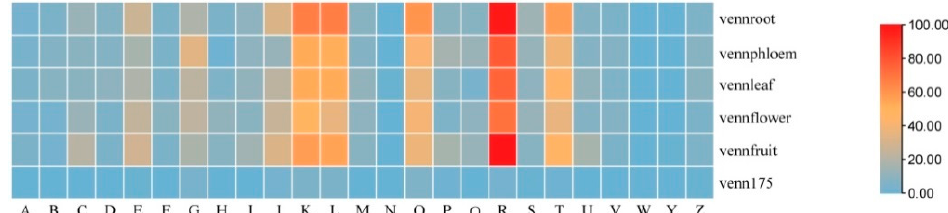
Figure 5. Cluster of genes (COG) classifications of parent genes (protein-based genes) of tissue